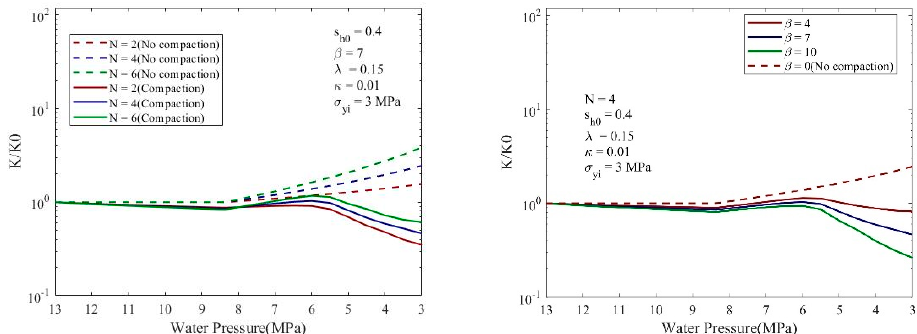
Figure 12. The effect of parameters N and β on permeability ratio K/K 0 (Left figures—N, Right figures— β ).